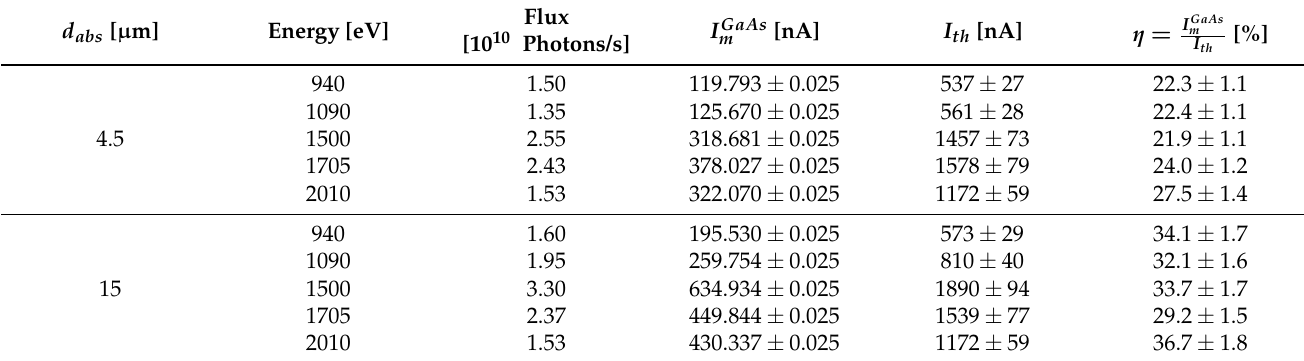
Table 2. Measured currents at different photon energies. The expected theoretical currents (column 5) were calculated from the photon energy and the photon flux by using Equation (8). The ratio between the measured and theoretical currents is reported in column 6. As before, the fluctuations associated with the photon energy were governed by systematic errors, in the order of 5 eV.